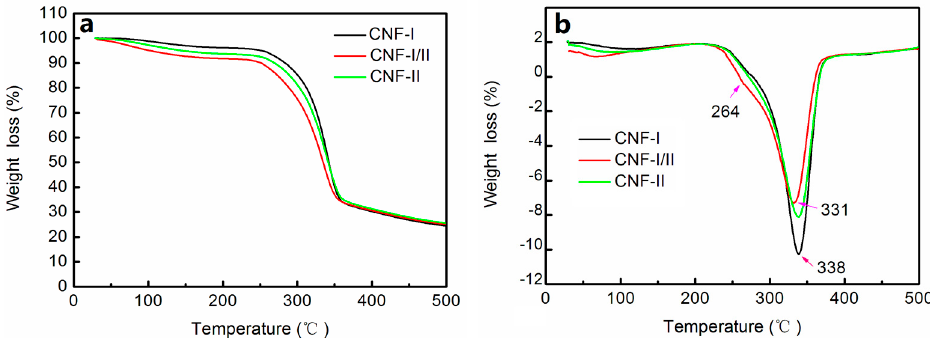
Figure 9. TG ( a ) and DTG ( b ) curves of CNF-I, CNF-I/II, and CNF-II films.